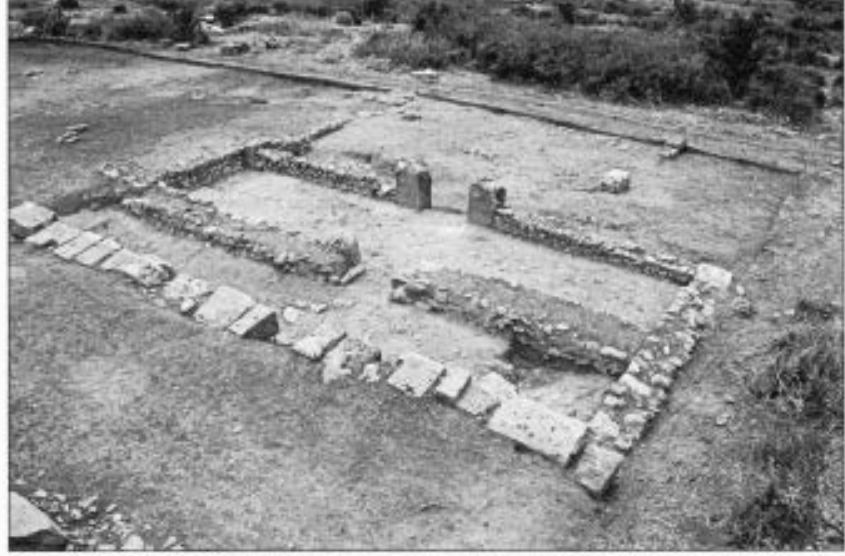
Figure 3 The northern medieval house at